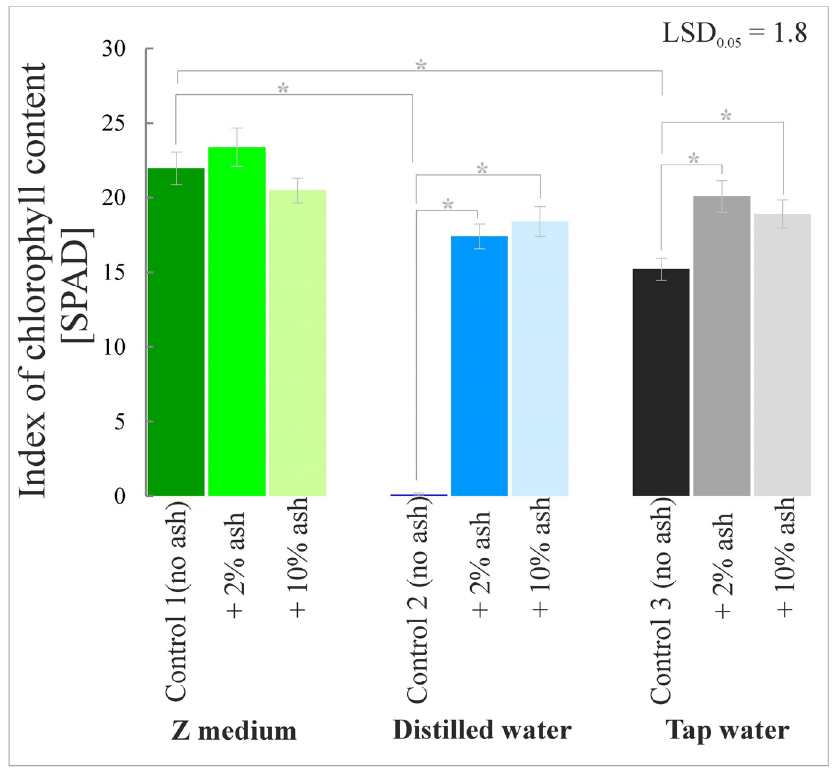
Figure 6. Index of chlorophyll content in S. polyrrhiza plants grown on different variants of ash- supplemented media. Bars denote means ± SE; asterisks show statistically significant differences between particular series; LSD at alpha level of 0.05.